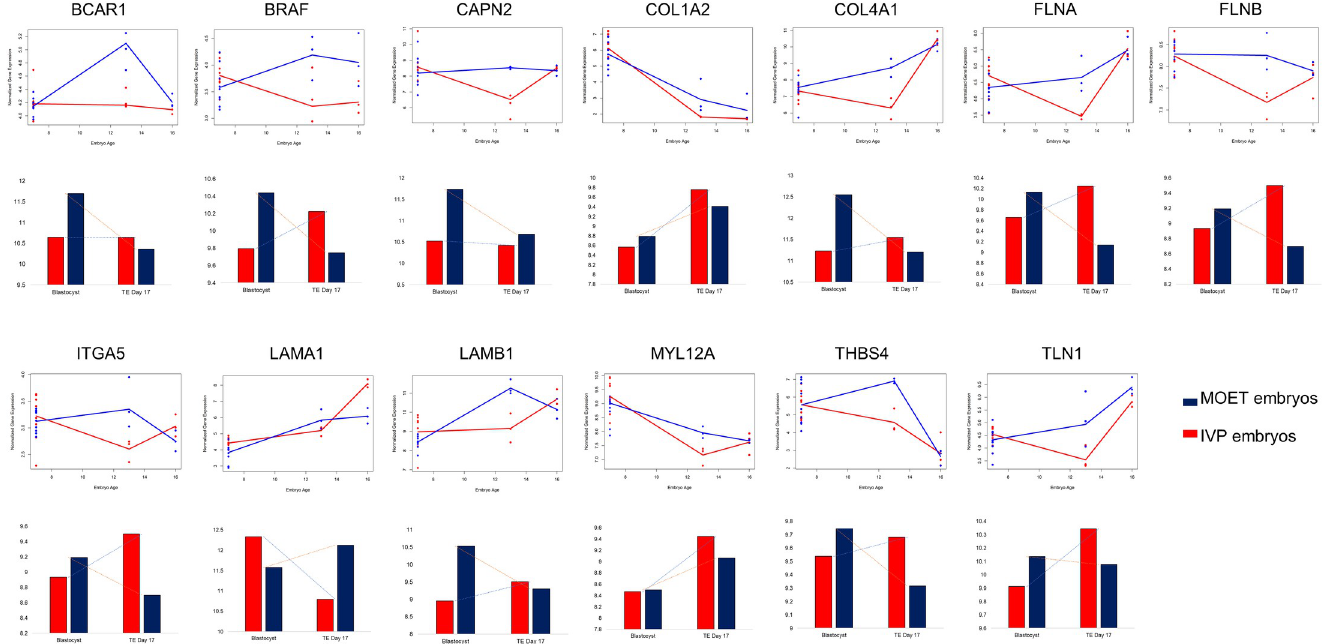
Fig 4. Differences in expression (line charts) and methylation (bar charts) levels in embryos produced in vitro or in vivo , from blastocyst to elongation. The expression levels are shown for blastocyst, day 13 and day 16 stages. The methylation levels are depicted for the blastocyst and the trophectoderm (TE) of day 17 embryos. Analysed genes are those involved in the "focal adhesion" KEGG pathway, which were part of the Cluster 1, determined as illustrated in Fig 2. BCAR1 : Cas family scaffolding protein; BRAF : B-Raf proto-oncogene, serine/threonine kinase; CAPN2 : calpain 2, (m/II) large subunit; COL1A2 : collagen type I alpha 2 chain; COL4A1 : collagen type IV alpha 1 chain; FLNA : filamin A; FLNB : filamin B; ITGA5 : integrin subunit alpha 5; LAMA1 : laminin subunit alpha 1; LAMB1 : laminin subunit beta 1; MYL12A : myosin, light chain 12A, regulatory, non-sarcomeric; THBS4 : thrombospondin 4; TLN1 : talin 1. Blue lines or bars correspond to embryos produced in vivo (after ovarian superovulation; MOET). Red lines or bars represent embryos produced in vitro (IVP).